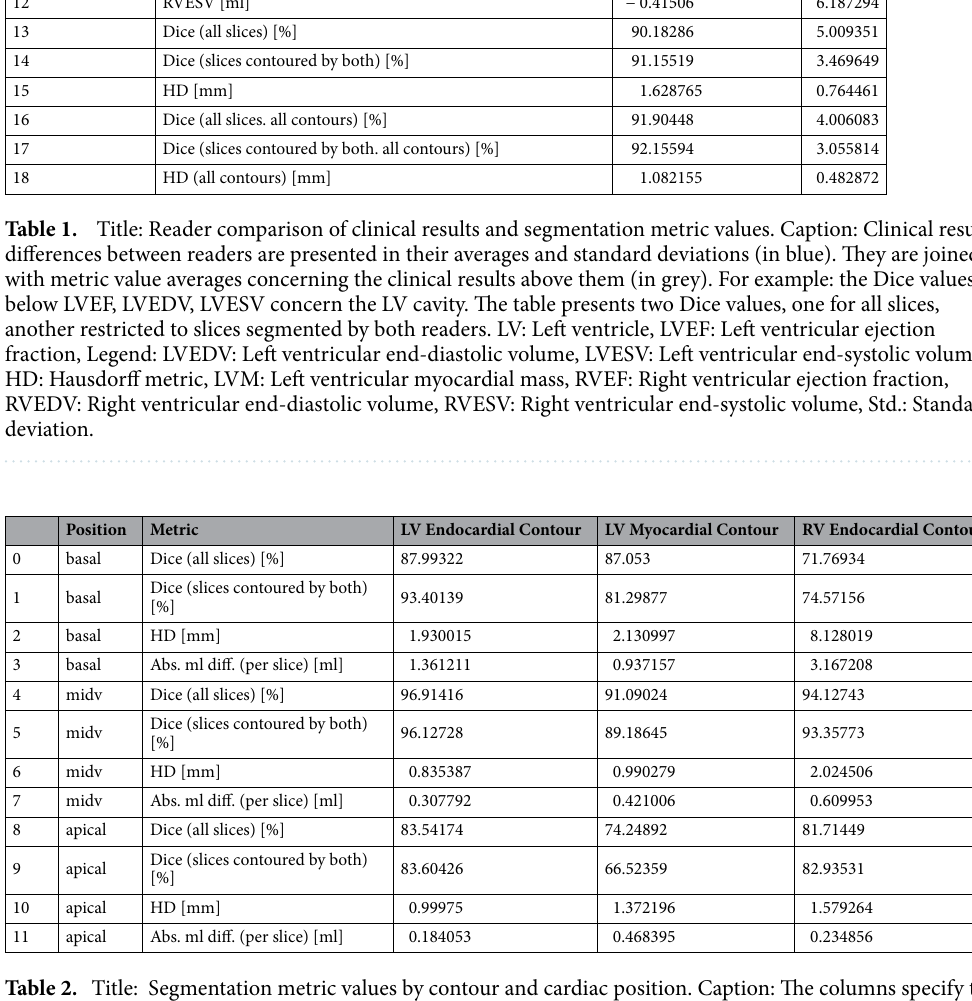
Table 2. Title: Segmentation metric values by contour and cardiac position. Caption: The columns specify the contour type. The sections refer to different cardiac positions (defined by the first reader). The table presents two Dice values, one for all slices, another restricted to slices segmented by both readers. Legend: Midv.: Midventricular, HD: Hausdorff metric, Abs. ml diff.: Absolute millilitre